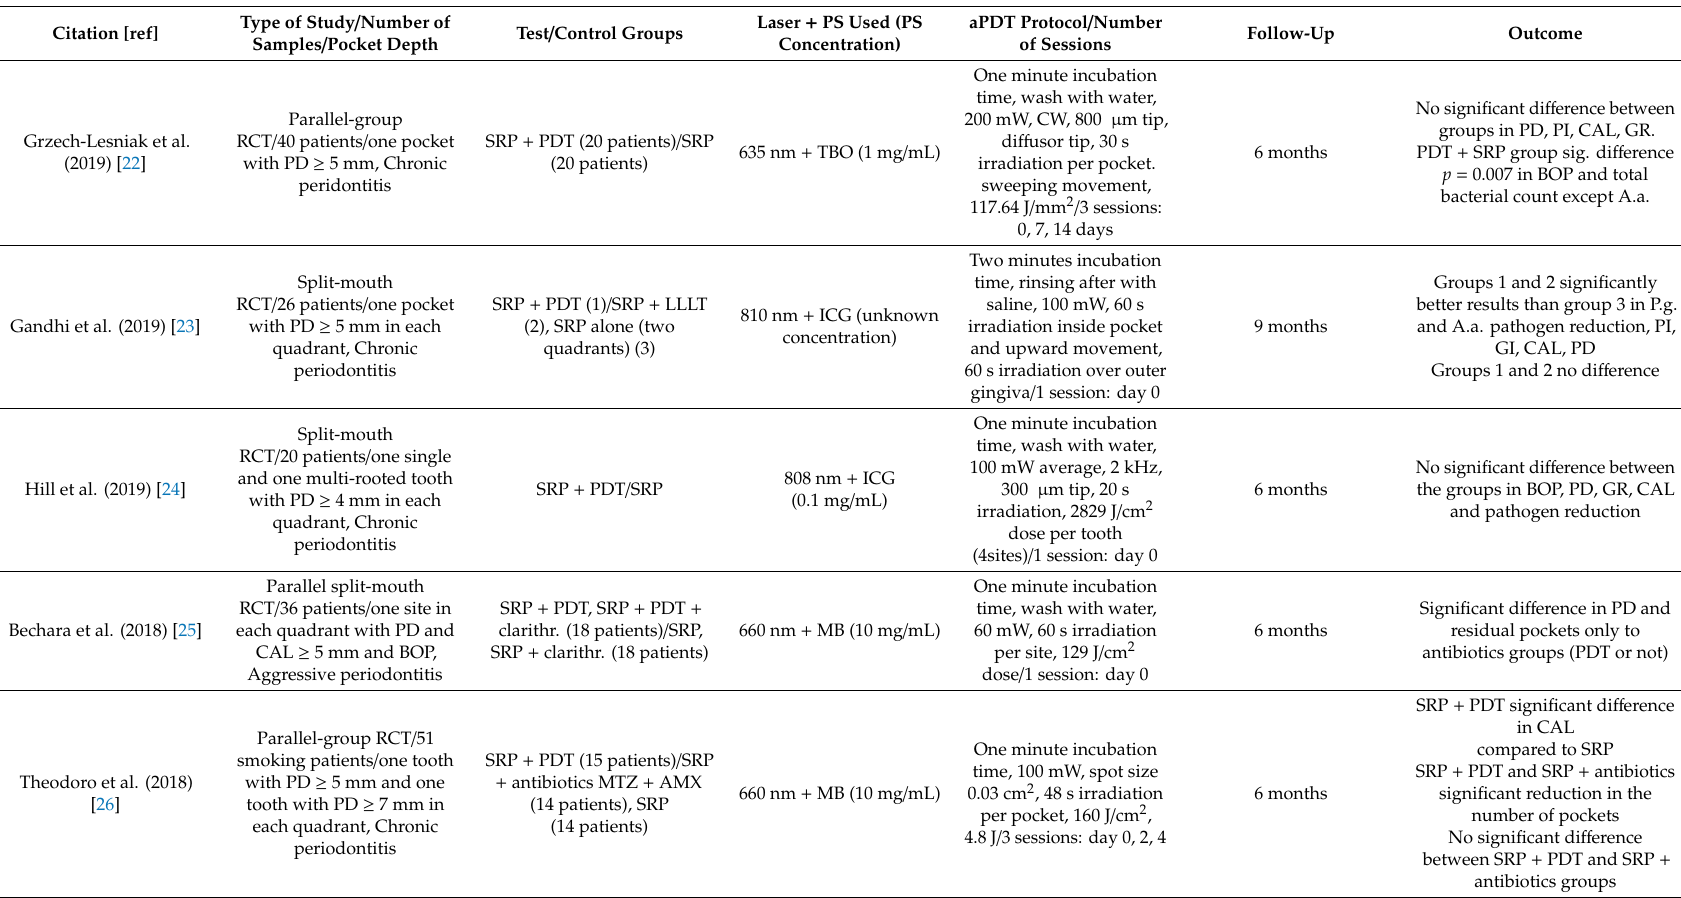
Table 1. Studies of aPDT in